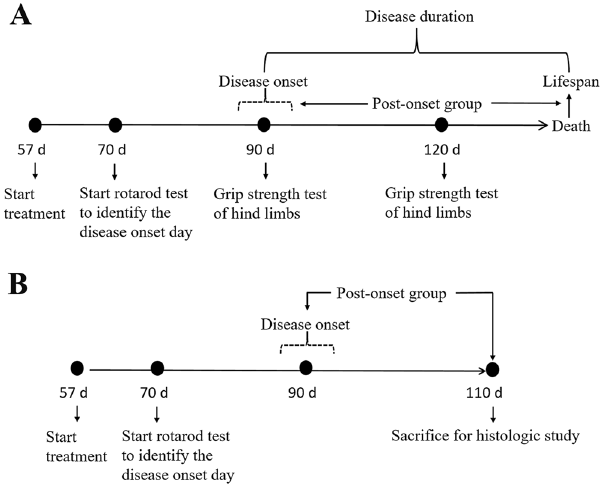
Figure 8. Schematic illustration of the experimental design. ( A ) The experimental process for the mice that were used to investigate the effect of HLSJ on the lifespan. ( B ) The experimental process for the mice that were used to study the histology and explore the possible